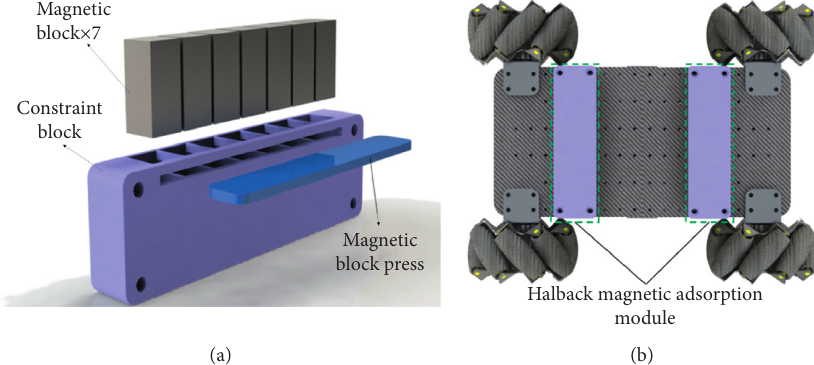
Figure 4: Halbach magnet arrangement rule diagram.